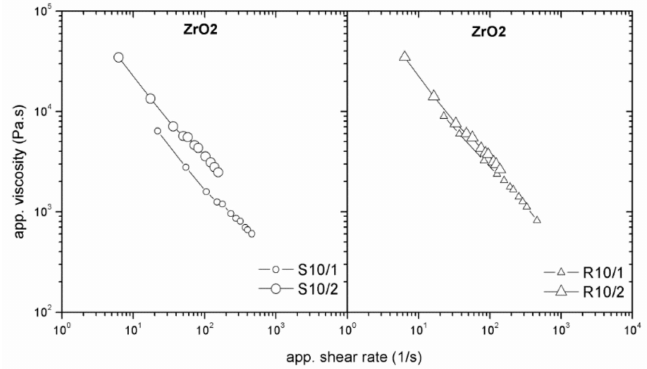
Figure 7. Effect of surface roughness on the flow properties of zirconium oxide (ZrO 2 )/LDPE+EVA+PW